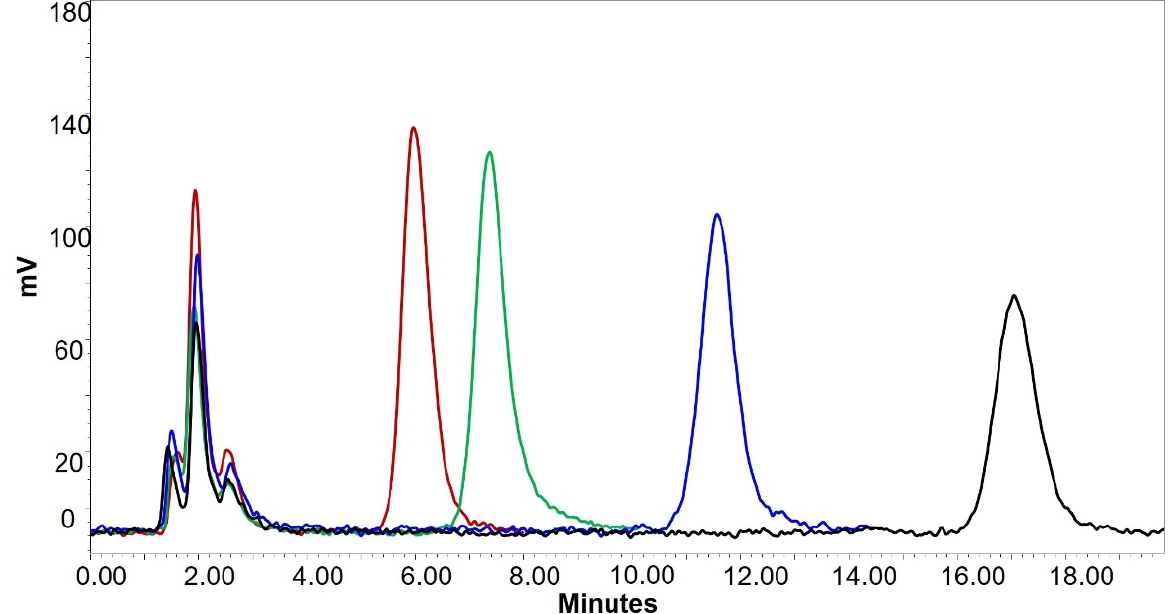
Figure 3. Superimposed HILIC-FL chromatograms of octreotide test solution at 1 µ g mL − 1 using various concentrations of ammonium bicarbonate (AMC) as a buffering salt in the mobile phase. Black line: 5 mM AMC; blue line: 10 mM AMC; green line: 15 mM; red line: 25 mM AMC. Chromatographic conditions: BEH XBridge ® -HILIC analytical column; mobile phase acetonitrile/aqueous solution of ammonium bicarbonate (70:30, v/v ); flow rate—0.25 ml min − 1